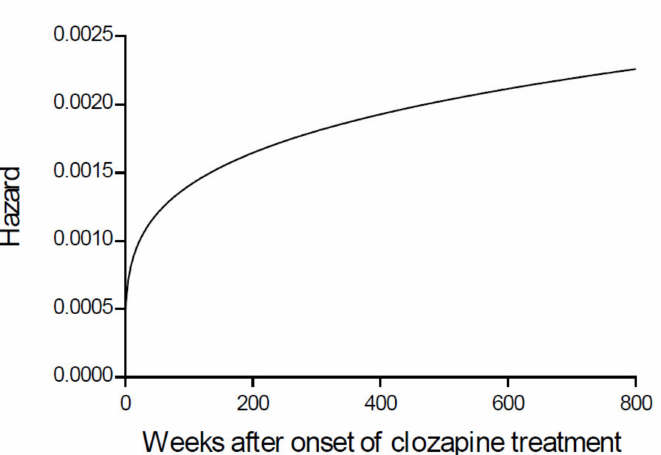
Figure 1. Weibull base model illustrating the shape of improving positive symptoms hazard function in a time window of 800 weeks after the onset of clozapine treatment. The hazard is near zero at time zero, then exponentially increases following clozapine treatment.